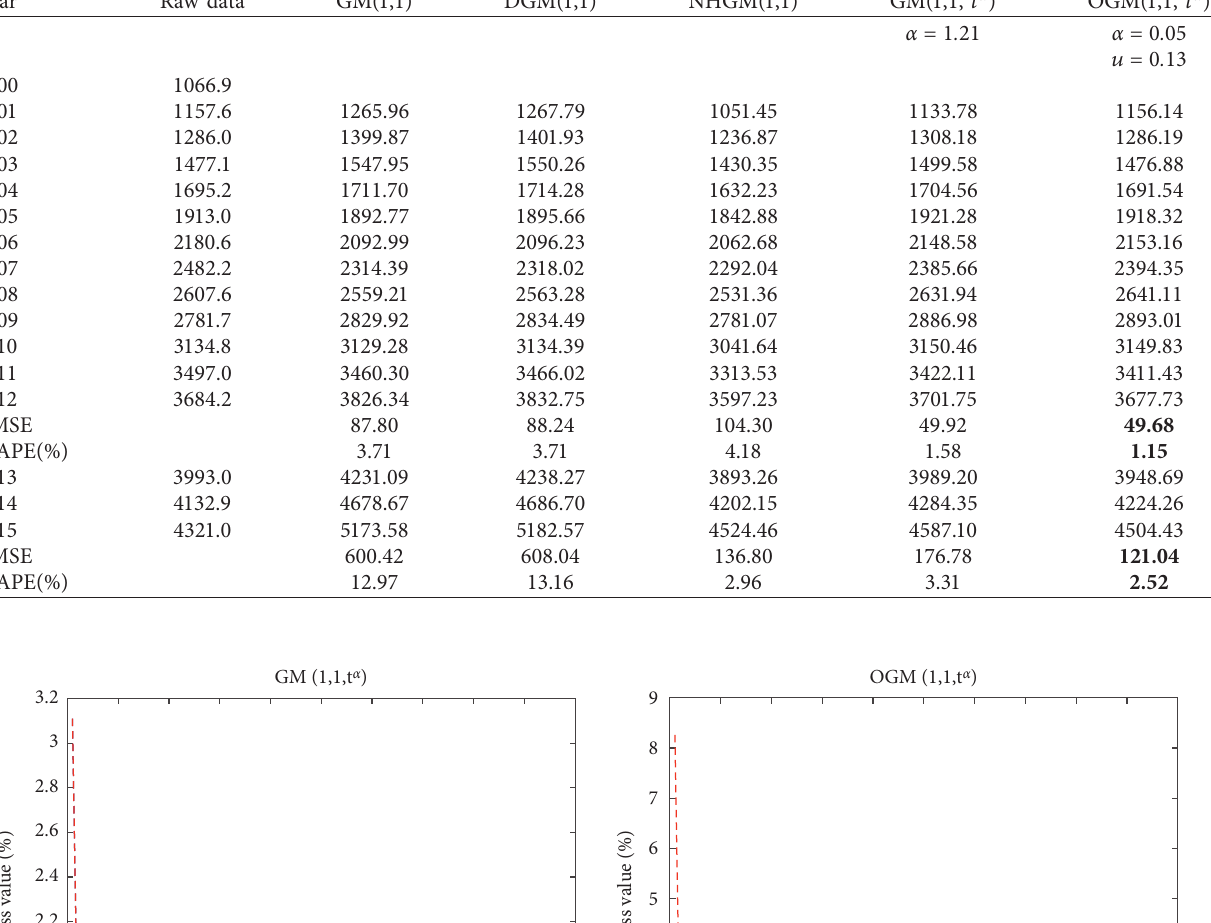
Table 2: The simulated results and indices by five grey models.